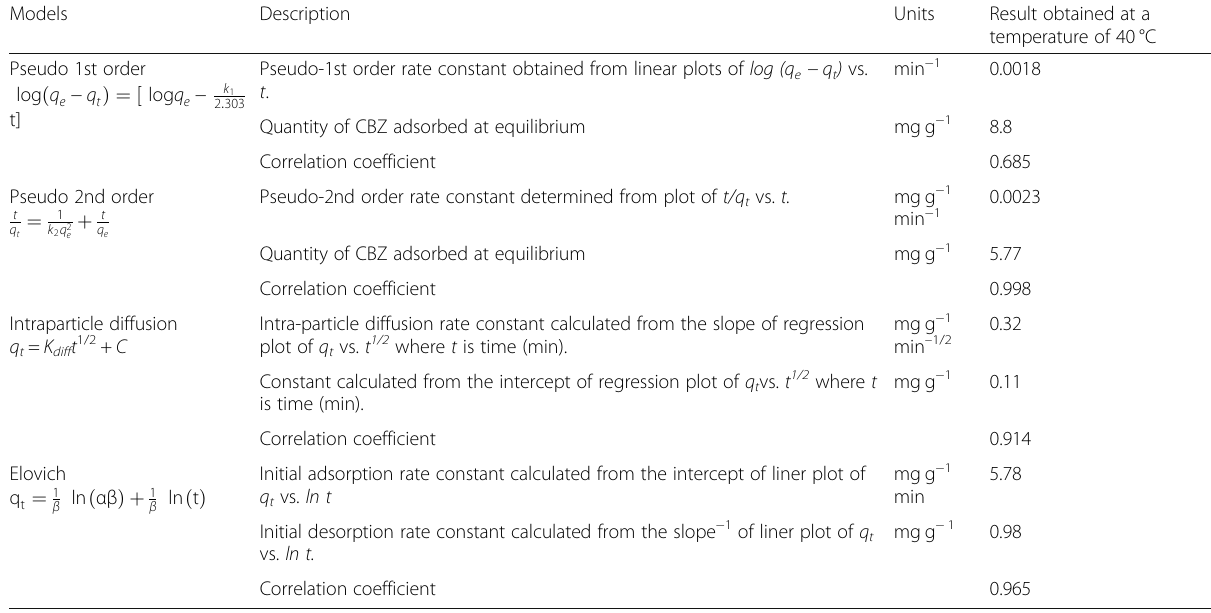
Table 3 Kinetic parameters for Carbamazepine (CBZ) adsorption by graphene oxide nanoplatelet (GONP)